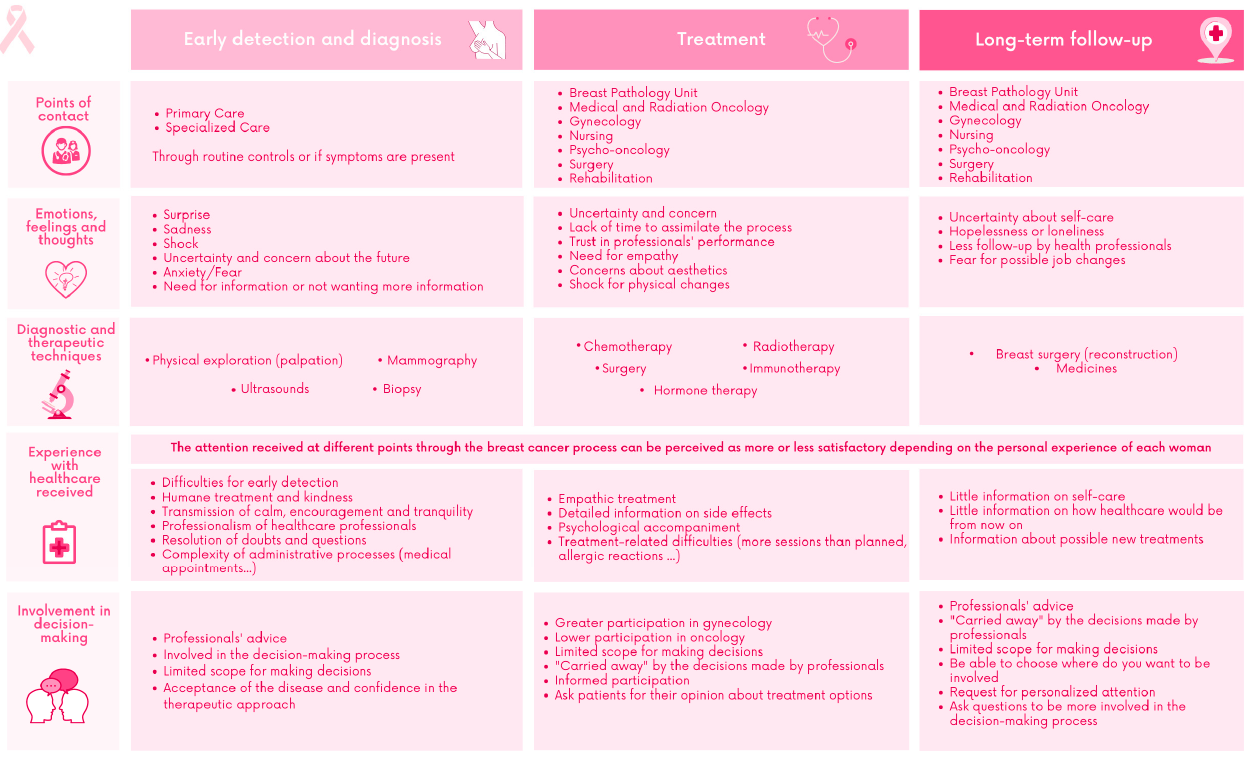
Figure 1. Patient Journey Map.